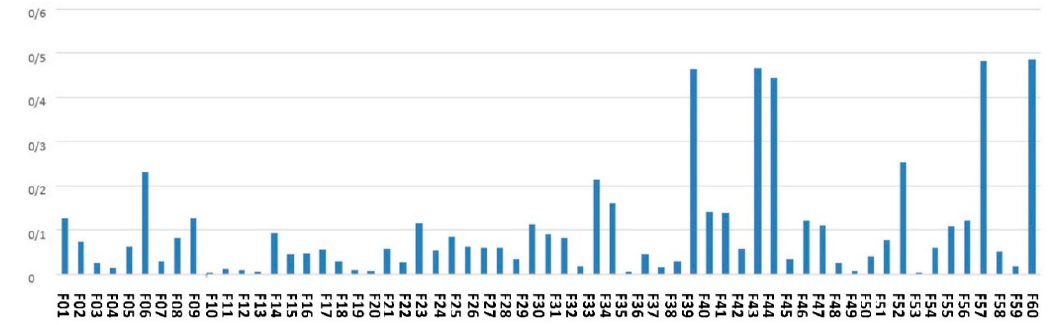
Figure 4. The average of the feature scores obtained by ensemble of filter-based feature scoring method.